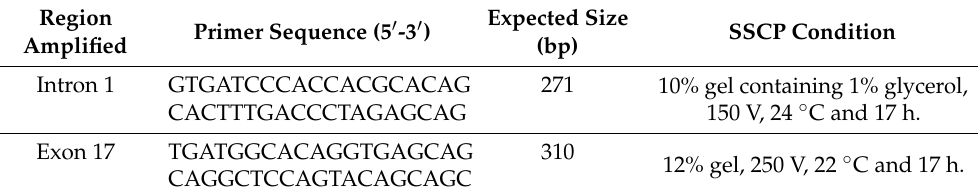
Table 1. PCR primers and SSCP analysis conditions for the two DGAT1 regions.